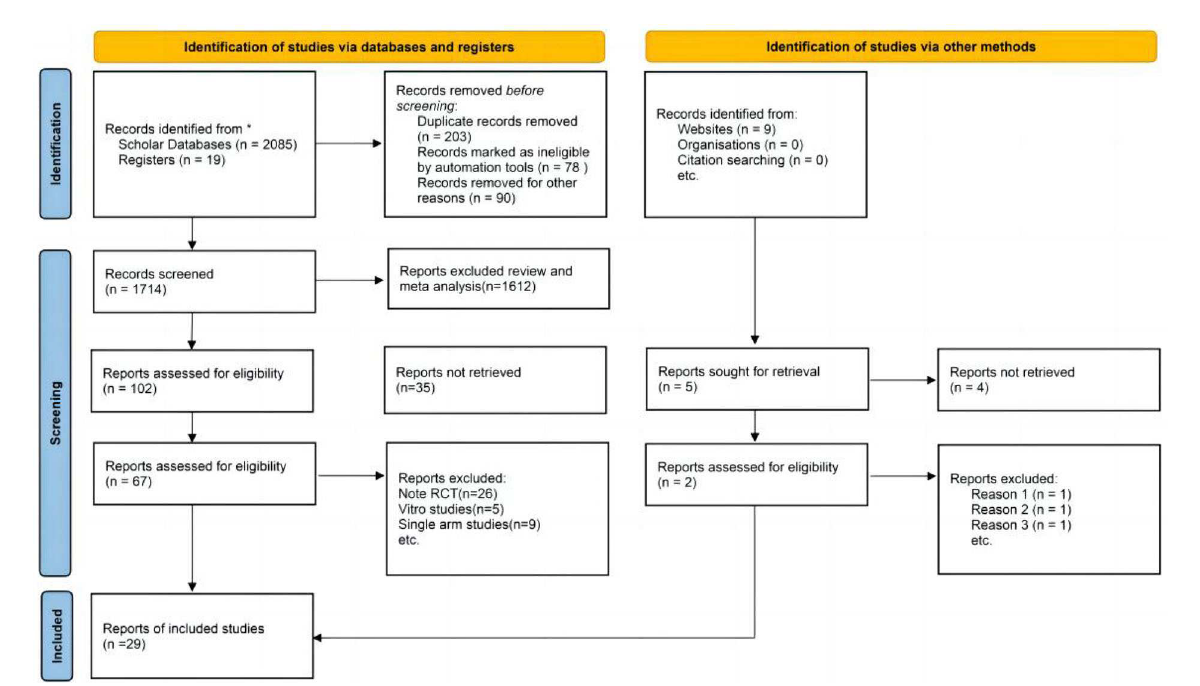
FIGURE1 Preferred reporting items for systematic reviews and meta-analyses (PRISMA) flow diagram of study search and selection for the